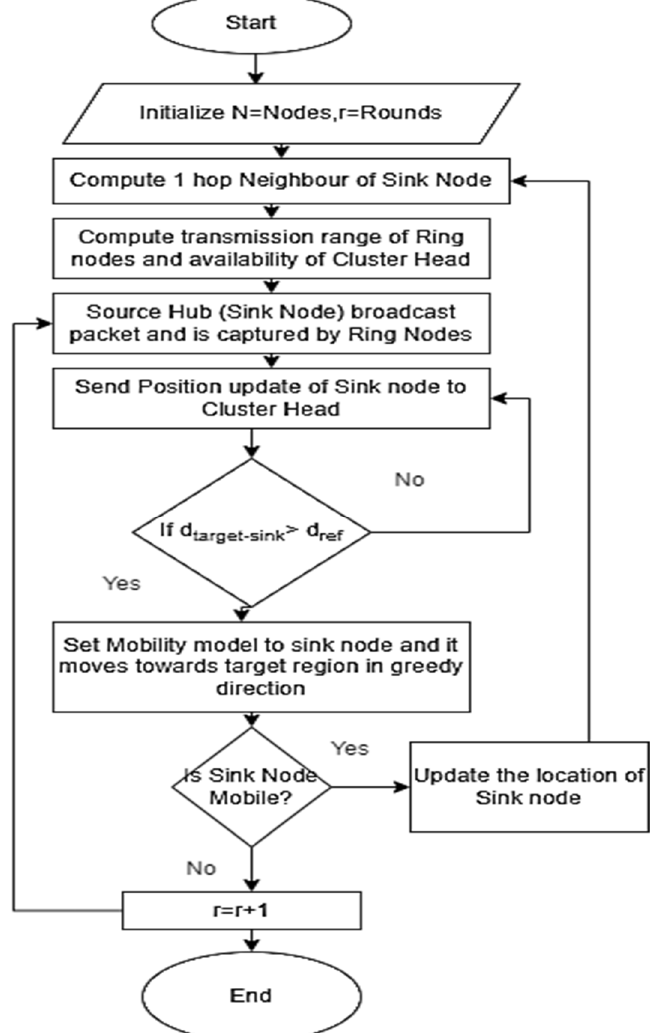
Figure 2. Flowchart for the inter cluster communication in the WSN.